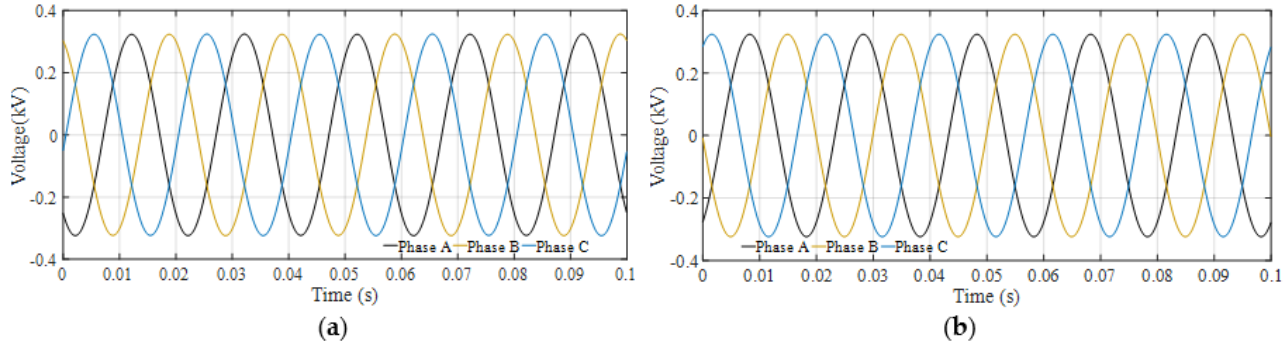
Figure 29. Three-phase voltage signals at the secondary side. ( a ) Affected by harmonic and ( b ) operating EVs as active filter.